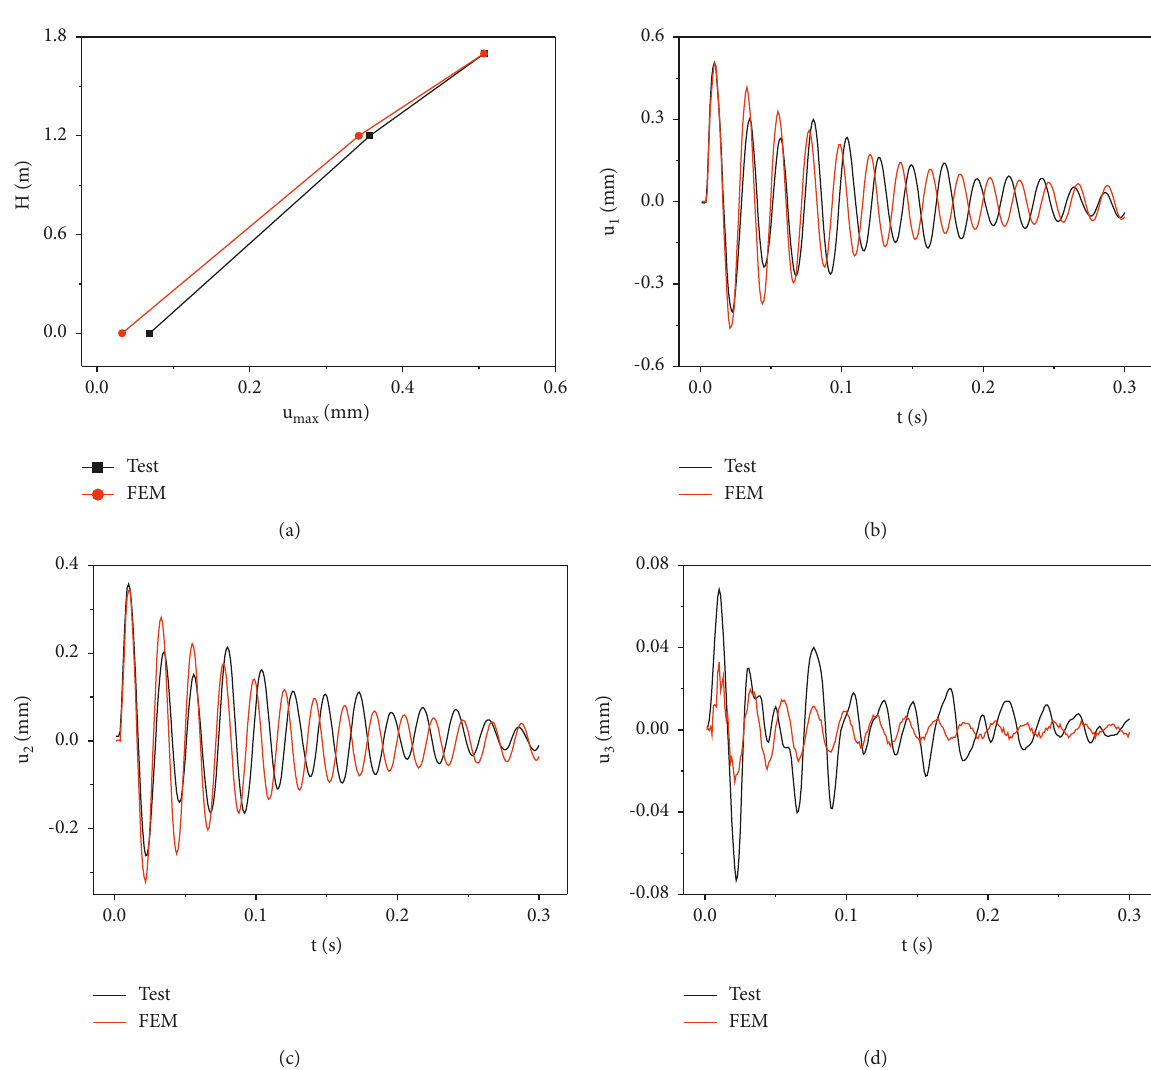
Figure 4: Displacement of pile body under impact of 0.12m pendulum height. (a) Maximum lateral displacement; (b) time history curve of u1; (c) time history curve of u2; (d) time history curve of